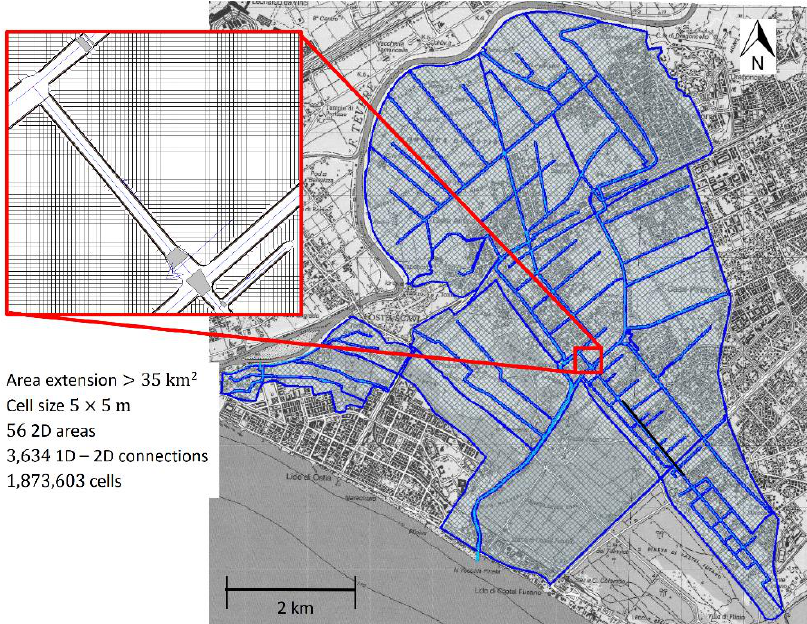
Figure 4. Domain discretization of the HEC-RAS 2D numerical model and specification of the number of elements adopted.